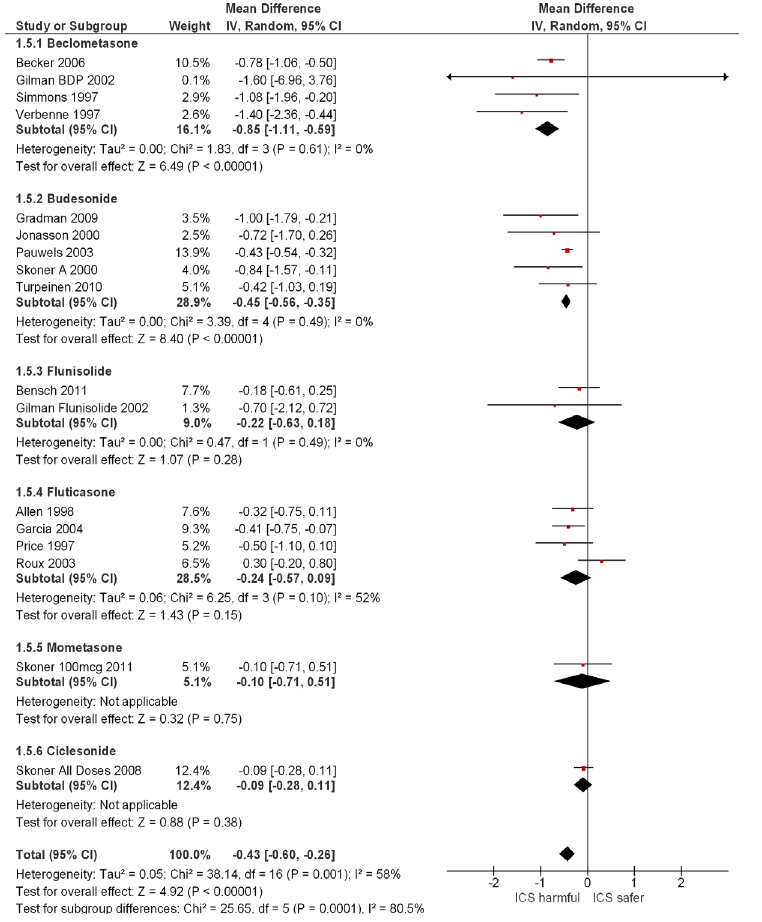
Fig 1. Growth Velocity in RCTS at 12 months follow-up.